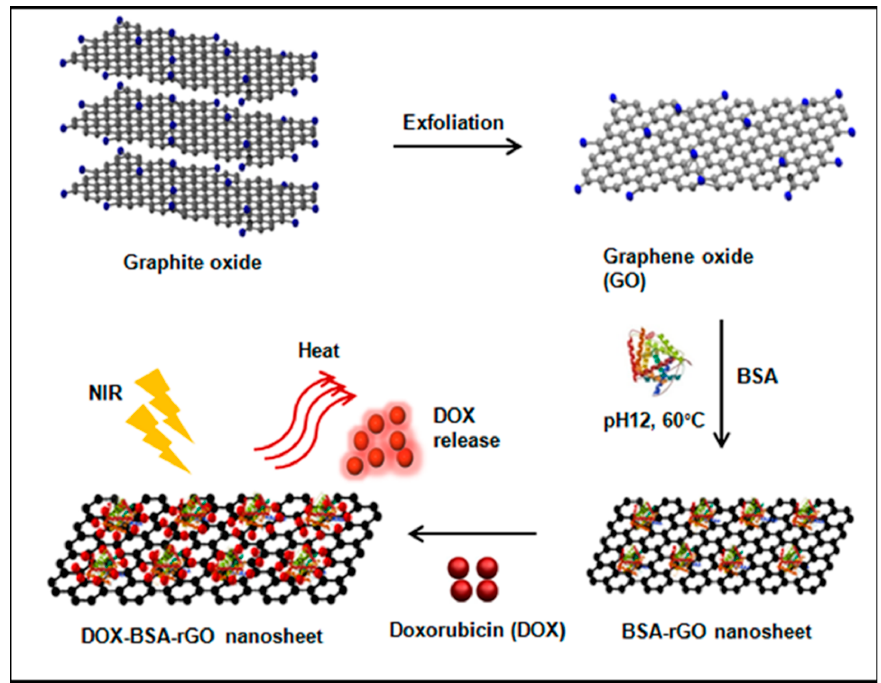
Figure 6. Synthesis and application of rGO as a DOX drug carrier. (Reproduced from Ref. [86] with permission from American Chemical Society. Copywrite 2016).